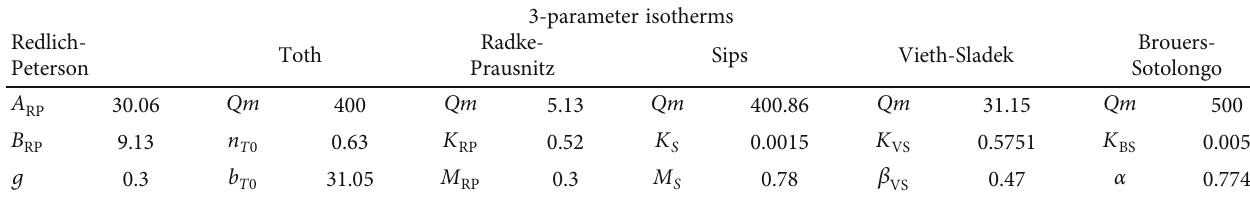
Table 6: Calculated parametric values of 3-parameter isotherms.